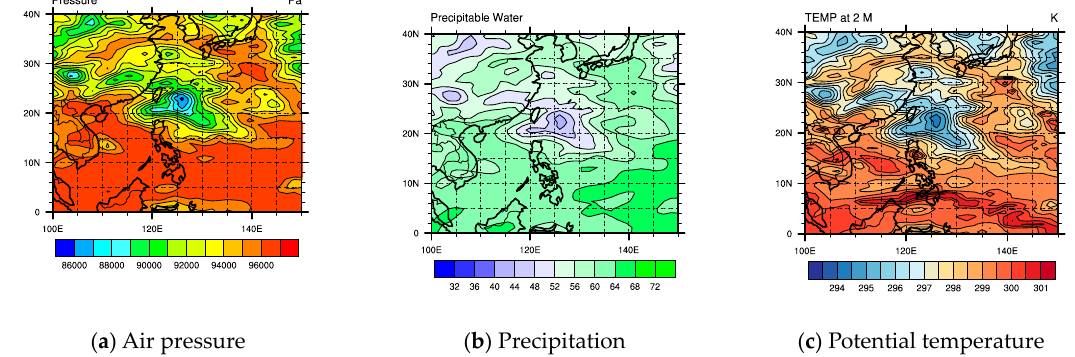
Figure 3. Air pressure, precipitation and potential temperature nephograms at landing.